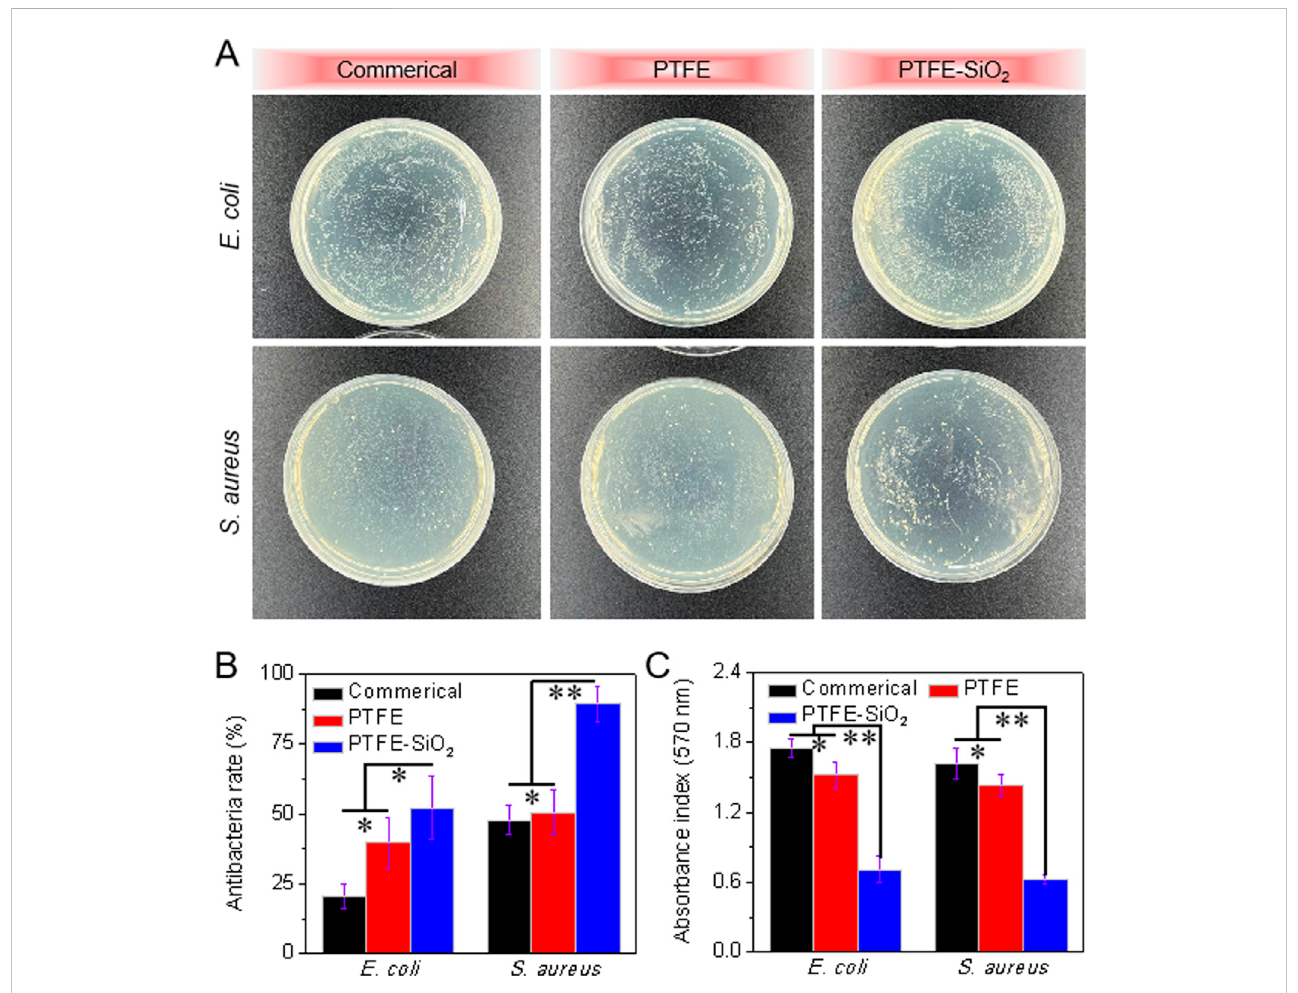
FIGURE 7 Quantitative analysis of the antibacterial properties of catheter: (A) Conoly-counting assay of catheter against E. coli and S. aureus ; (B) Antibacterial rate of catheter after 6 h incubation with E. coli and S. aureus (quantitative analysis of colony statistics); (C) Quantitative analysis of photometric method after 6 h incubation with E. coli and S. aureus . ( n = 5, *p < 0.05 , **p < 0.01